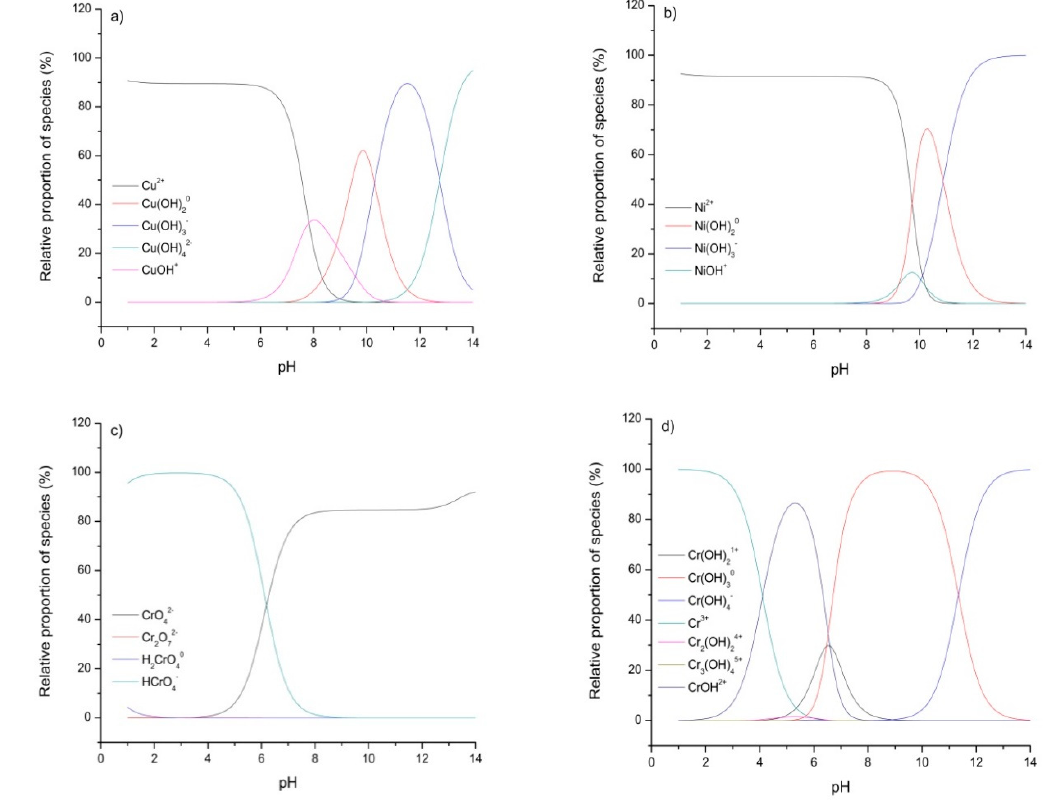
Figure 8. Relative proportion of: ( a ) Cu(II), ( b ) Ni(II), ( c ) Cr(VI) and ( d ) Cr(III) species as a function of pH ( C 0 = 1 mg L − 1 , ionic strength = 0.1 M NaNO 3 , T = 298 K).